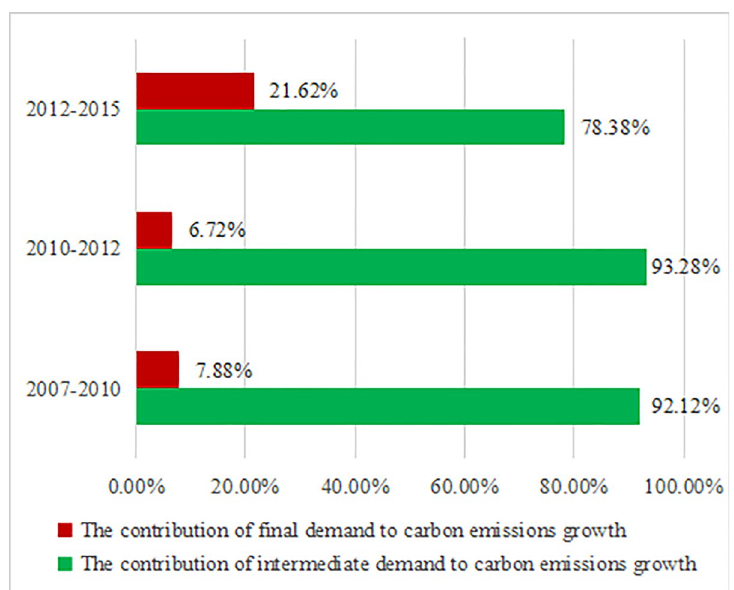
Fig 4. The contributions of intermediate demand and final demand to carbon emissions growth from 2007 to